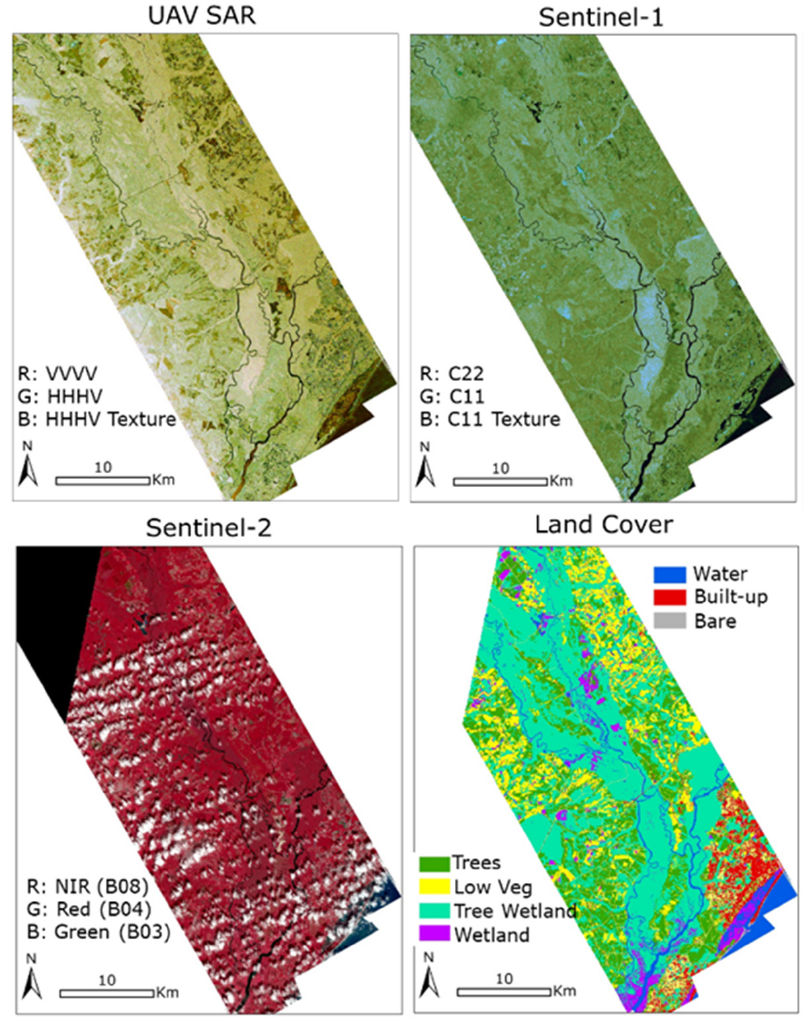
Figure 1. Overview of the study area located in coastal South Carolina, USA. The UAVSAR, de-noised Sentinel-1 and Sentinel-2 multispectral imagery are all shown. The land cover type map used for training data stratification and error evaluation is also shown.